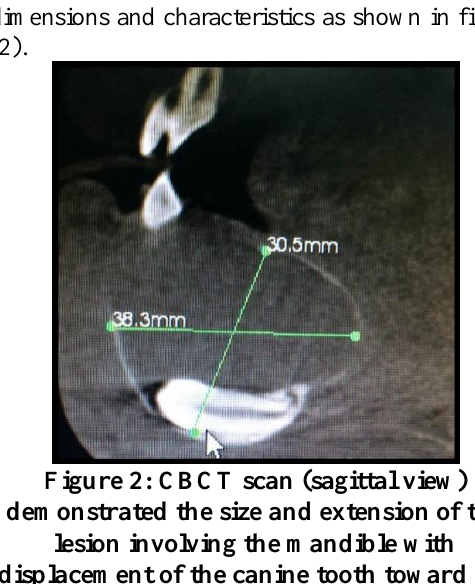
Figure 2: CBCT scan (sagittal view) demonstrated the size and extension of the lesion involving the mandible with displacement of the canine tooth toward the lower border of the